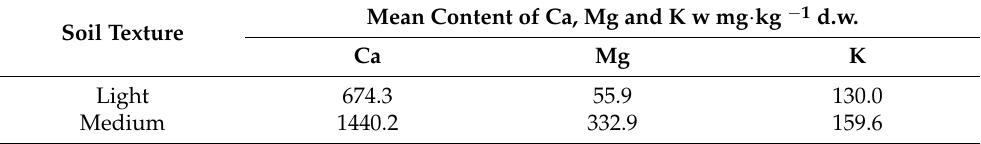
Table 2. Mean content of exchangeable cations (mg · kg − 1) in the top layer of light and medium soils (0–30